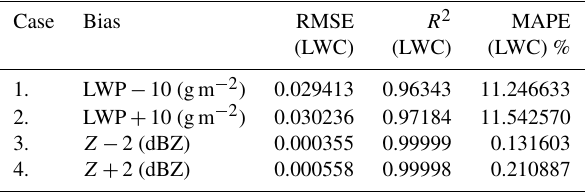
Table 8. Error in retrieved LWC for various biases in assimilated LWP.